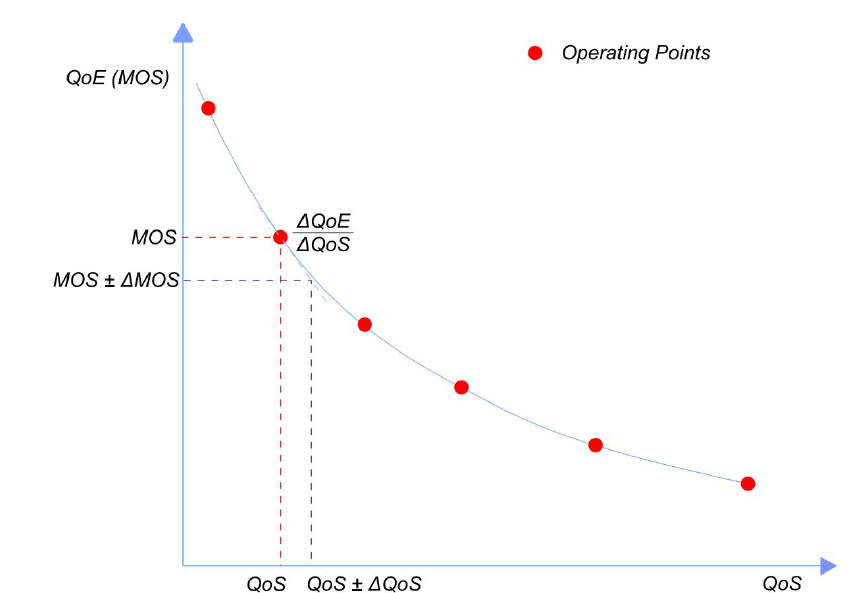
Figure 1. Propagation of uncertainty in Quality of Experience (QoE) due to fluctuation in Quality of System